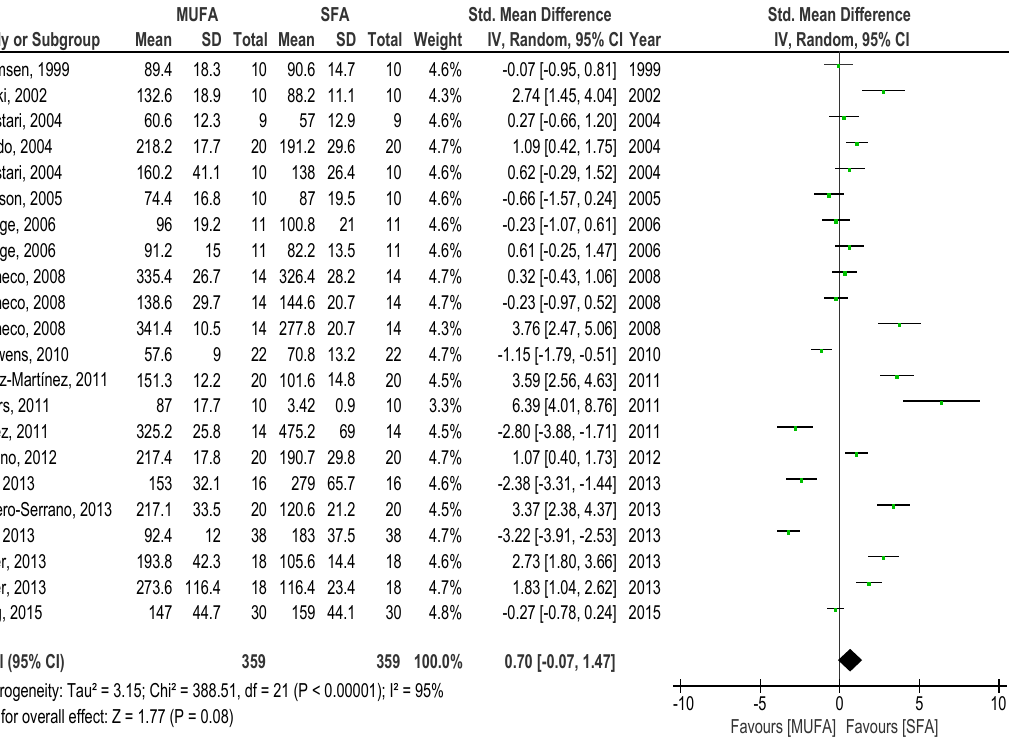
Figure 5. Forest plot of postprandial triglycerides of saturated fatty acids compared to monounsaturated fatty acids over 4 hours.